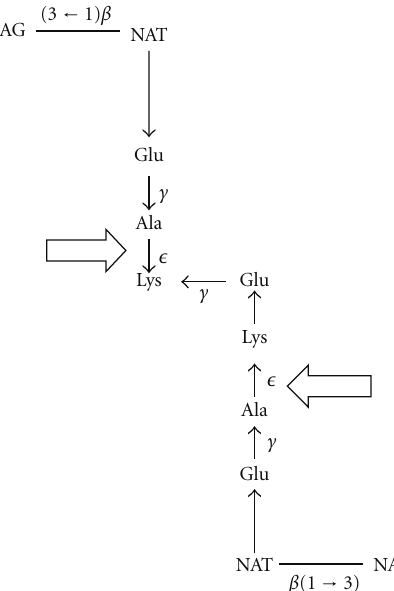
Figure 1: Dimer structure of pseudomurein and cleavage sites of pseudomurein endoisopeptidase (Pei). Block arrows indicate the cleavage site of Pei in the peptide subunit. The picture was adapted and modified from Kiener et al.